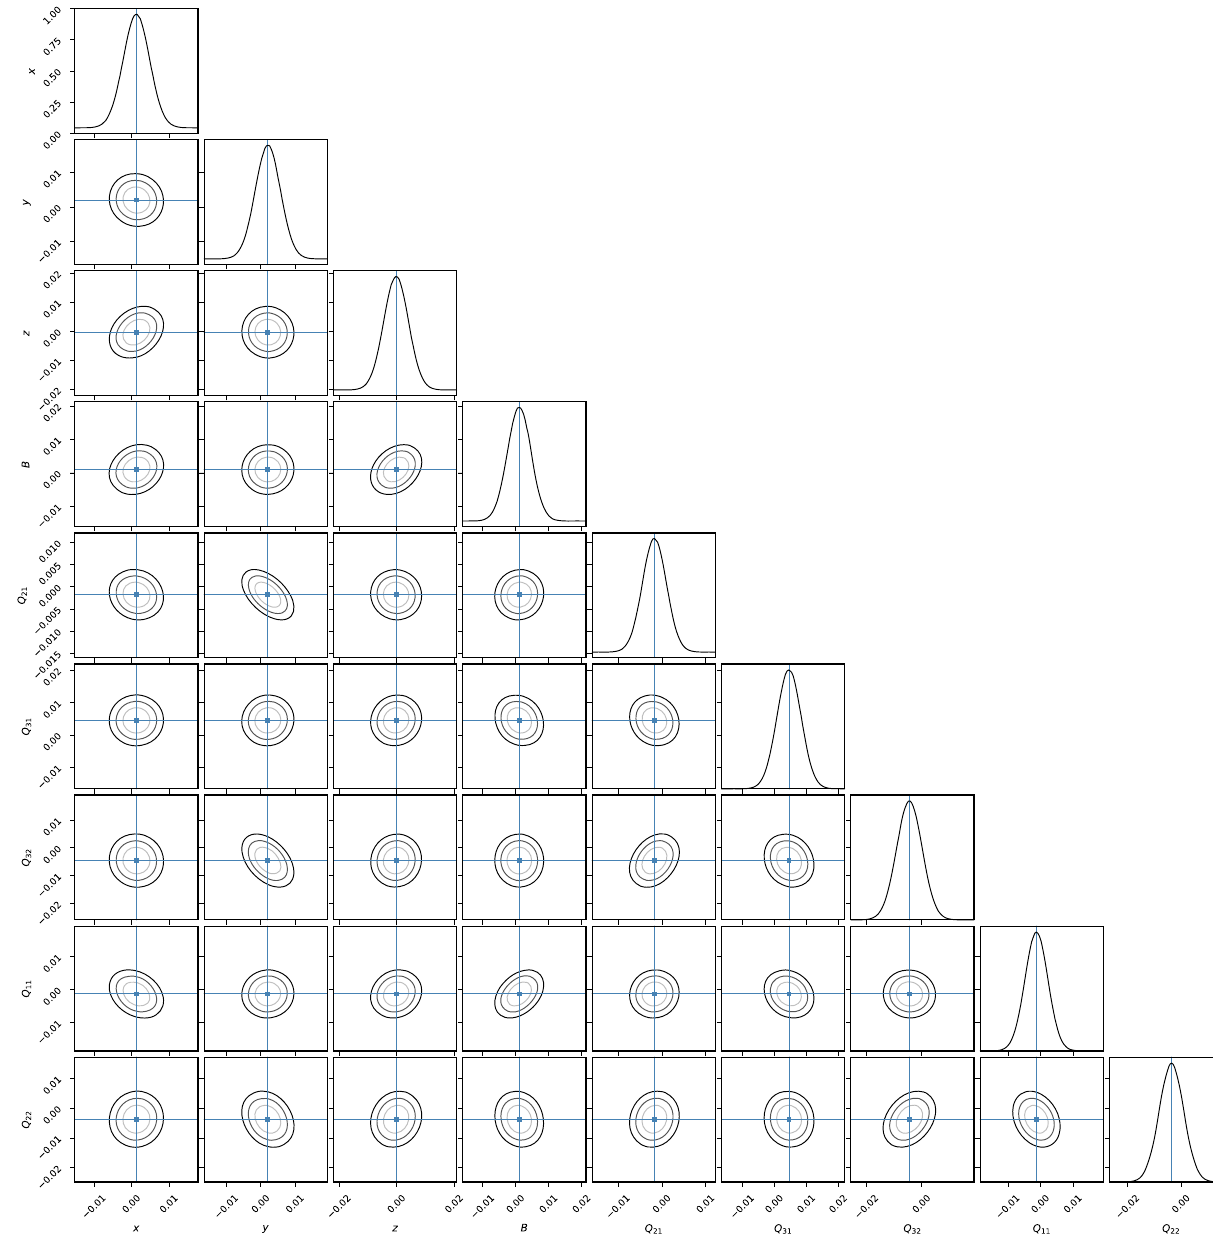
Fig. 14 Probability distribution functions of dipole and quadrupole parameters